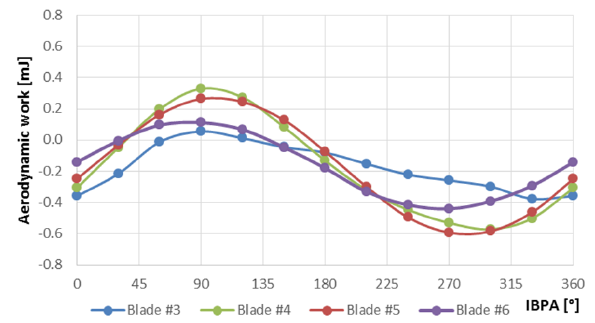
Figure 14. Blade torsion: aerodynamic work for the 4 vibrating profiles vs.